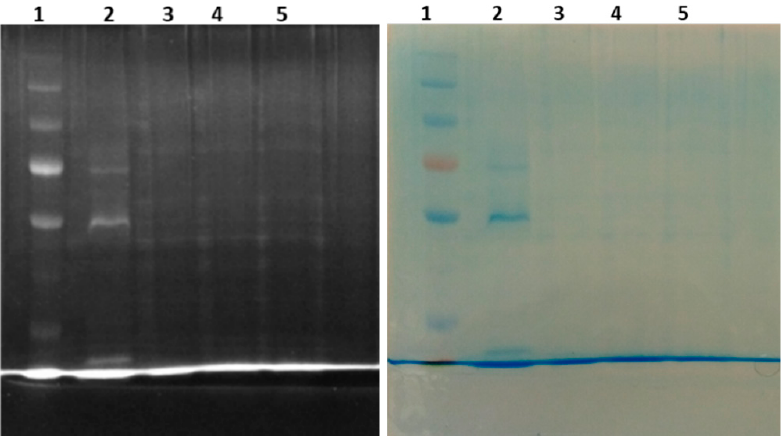
Figure 3. Protein marker, 2—venom, 3—Venom + volatile oil, 4—Venom + Non-volatile oil B and